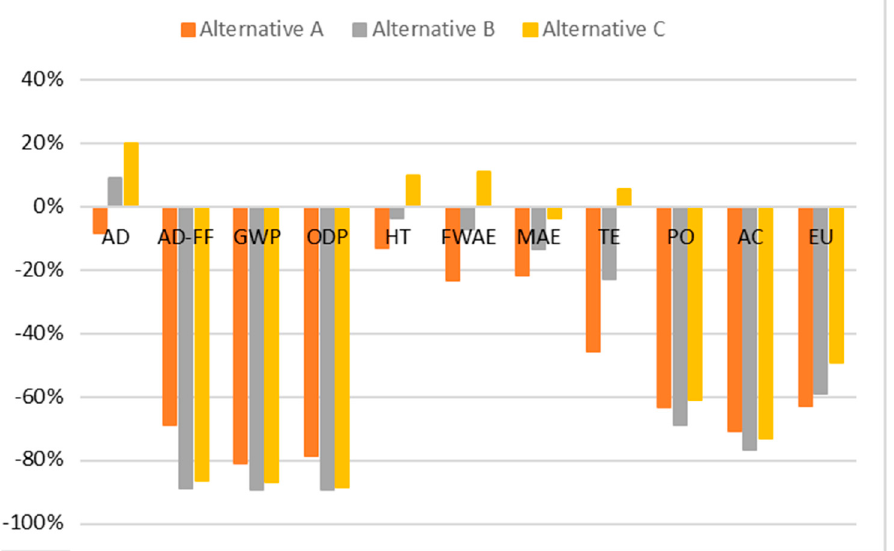
Figure 5. Bar chart of the increase or decrease rate per category compared to the base case for each of the alternatives.